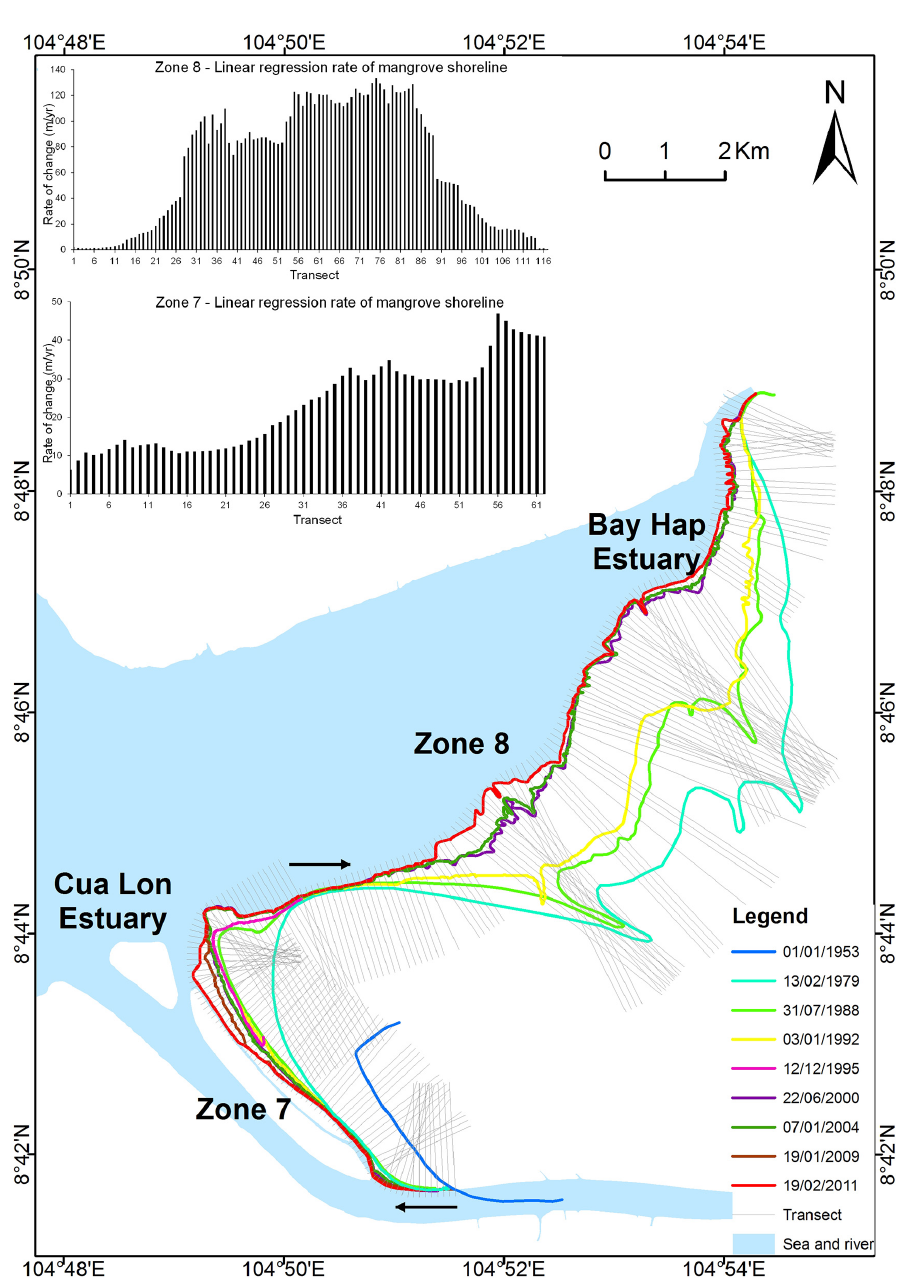
Figure 5. Mangrove shoreline change in zones 7 and 8. Mangrove shoreline 1953 is not observed in zone 8. DSAS software generated 62 and 117 transects for zone 7 and zone 8, respectively. The arrows show the direction of transects from 1 to 62 for zone 7 and from 1 to 117 for zone